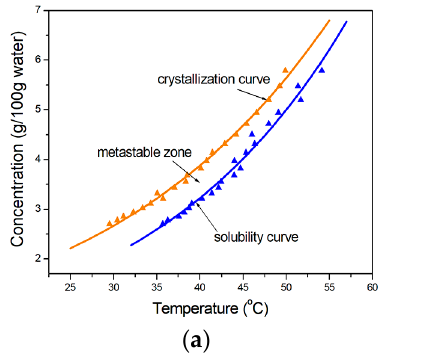
Figure 2. ( a ) TPPB solubility and crystallization curves in water. The triangles are the data measured. The solid curves are the fitted results based on the experimental data; ( b ) TPPB single-crystal with a size of 27 mm × 20 mm × 20 mm, grown by the temperature-lowering method.